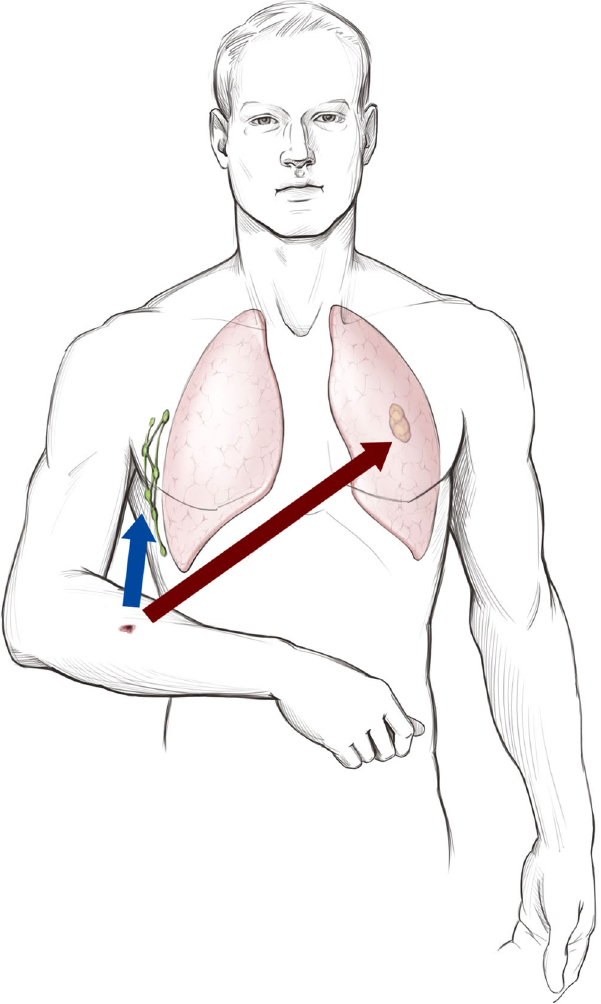
Fig. 1 Potential outcomes in patients with melanoma undergoing sentinel lymph node biopsy, demonstrating hematogenous and lymphatic metastasis. Acknowledgement and credit to Brian C. Brockway, M.S., Medical Media, Atlanta VA Medical